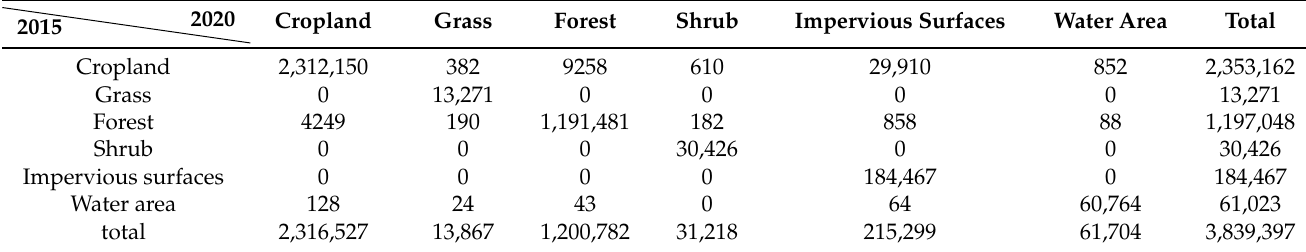
Table 3. Confusion matrix/error or land conversion from 2015 to